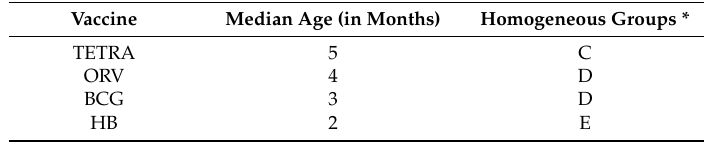
Note: * Different letters represent significantly different medians ( α = 0.05).